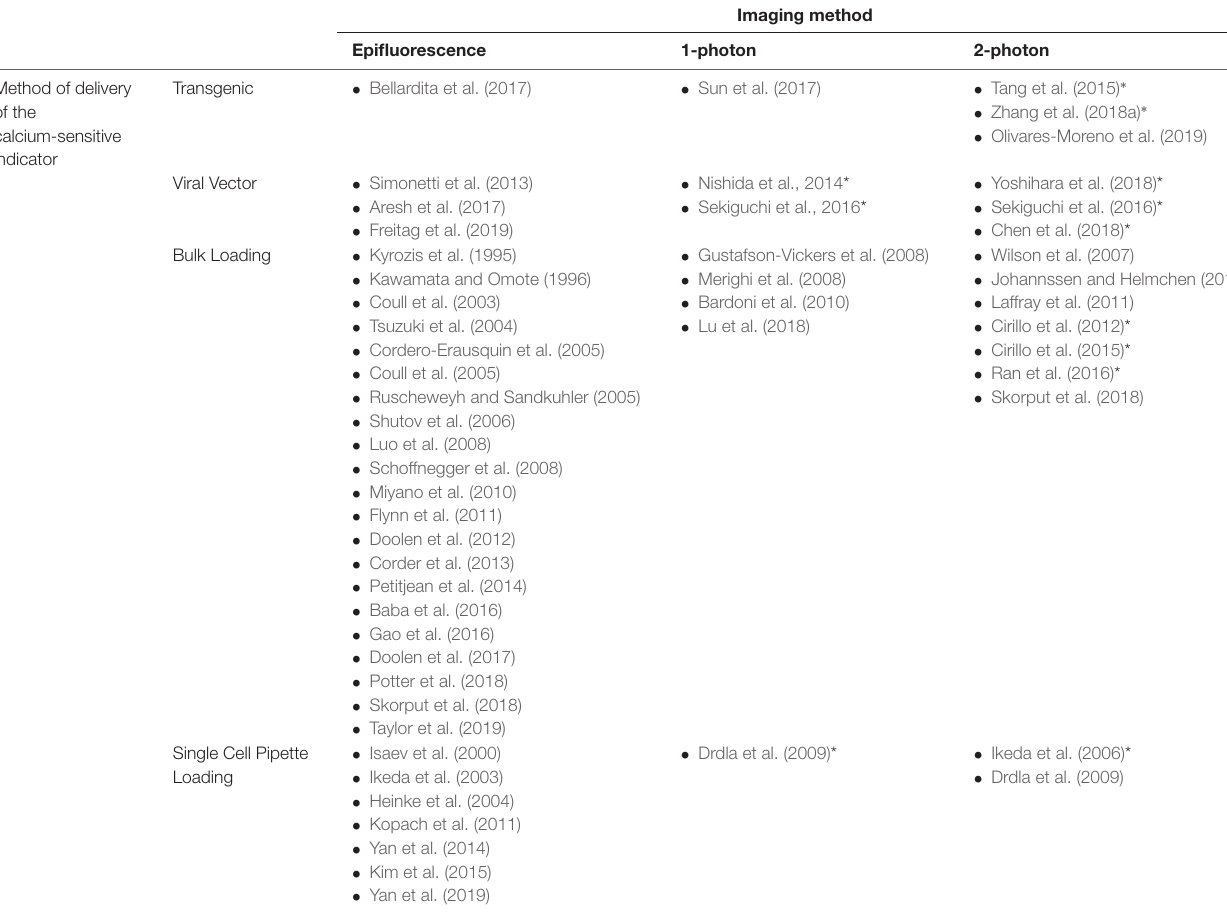
TABLE 2 | Summary of all publications utilizing calcium imaging for interrogation of spinal cord somatosensory